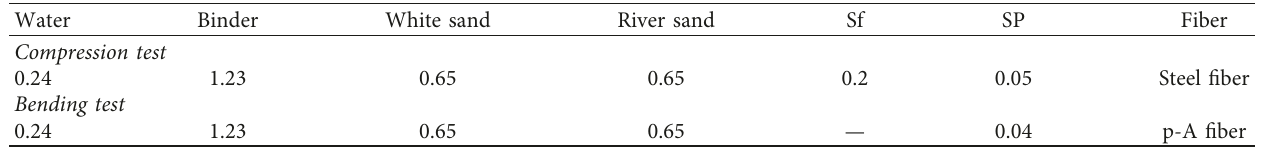
Table 1: Mix proportions.